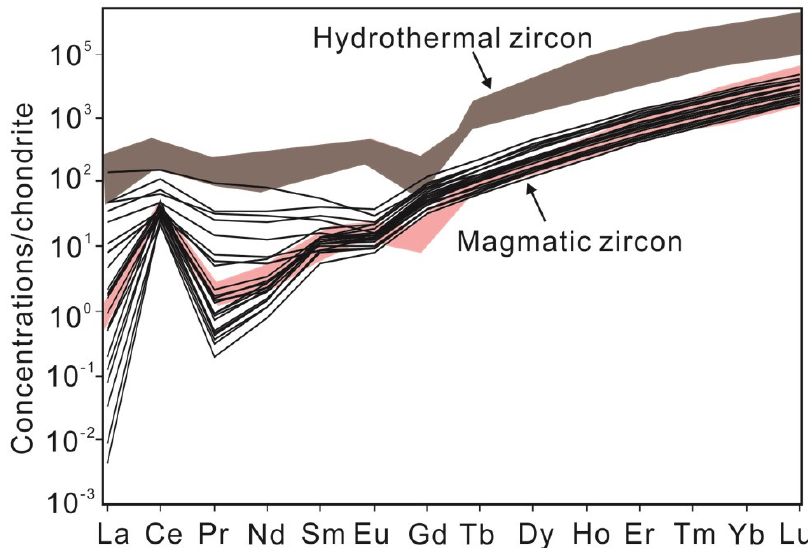
Figure 11. Chondrite normalized rare earth element distribution diagram of zircon grains from the No. 3 granodiorite. Reference fields of hydrothermal and magmatic zircons according to [56], chondrite values according to [52].